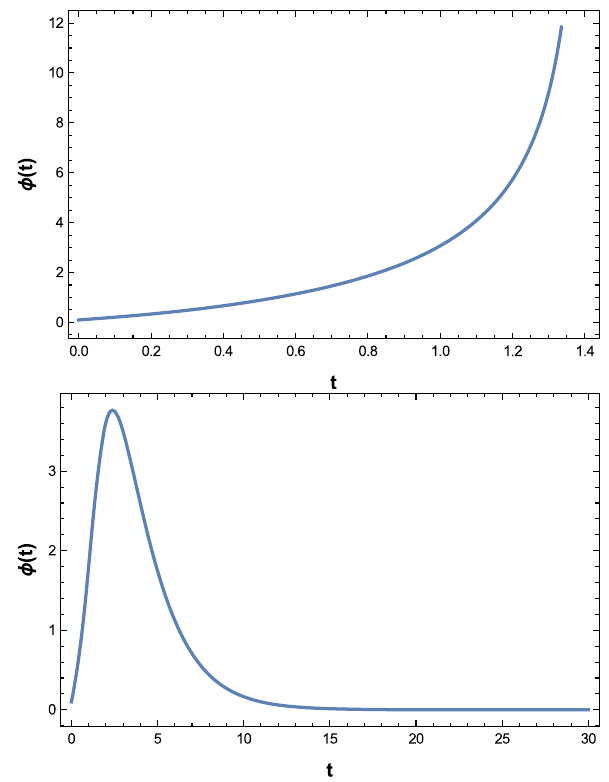
Fig. 6 Evolution of the scalar field for p = 1 √ and U 0 = 2. For the 2 graph on top, a 0 = 1. For the graph on bottom, a 0 = − 1. The initial conditions chosen for the numerical solutions are the values of a ( t ) and da ( t ) > for an initial time t i ; da ( t ) dt dt t = ti